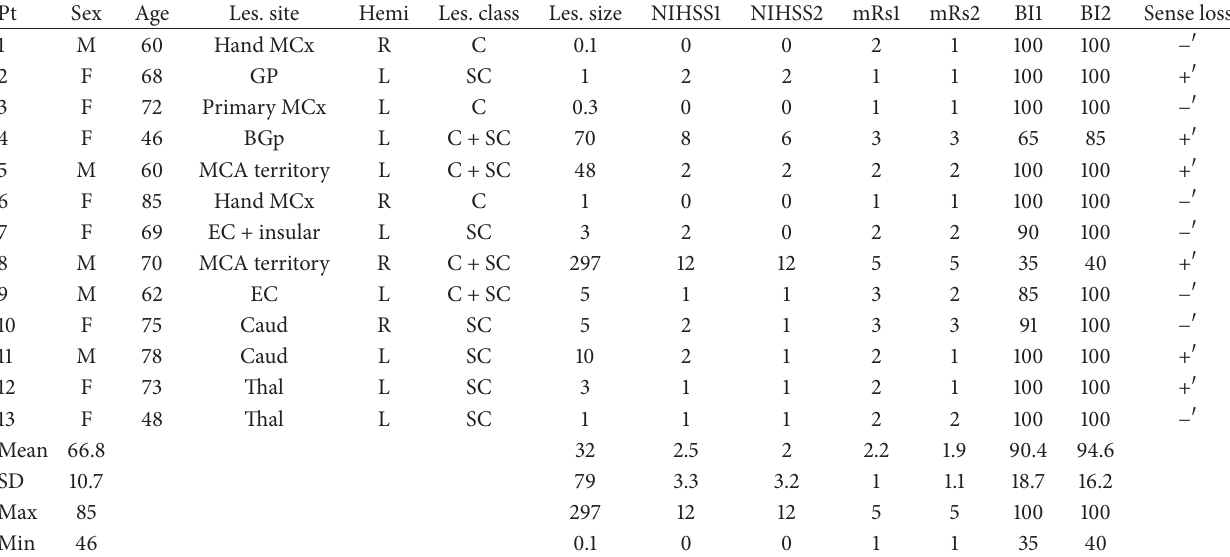
Table 1: Patient demographics and behavioral